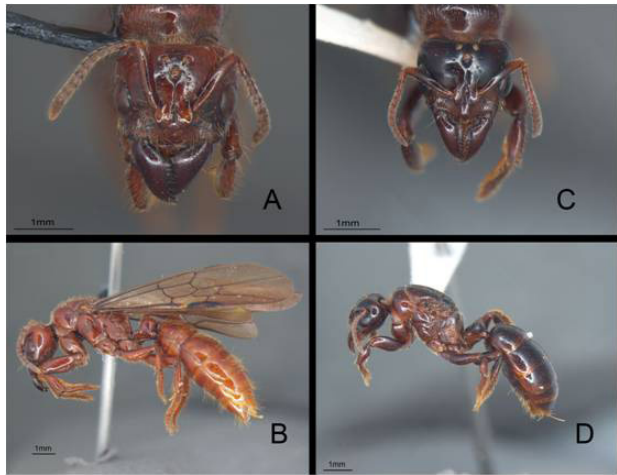
Fig 1 . Centromyrmex species of French Guiana. Centromyrmex gigas (A, B); Centromyrmex alfaroi (C, D) . A, C: full-face view; B, D: body in lateral view.